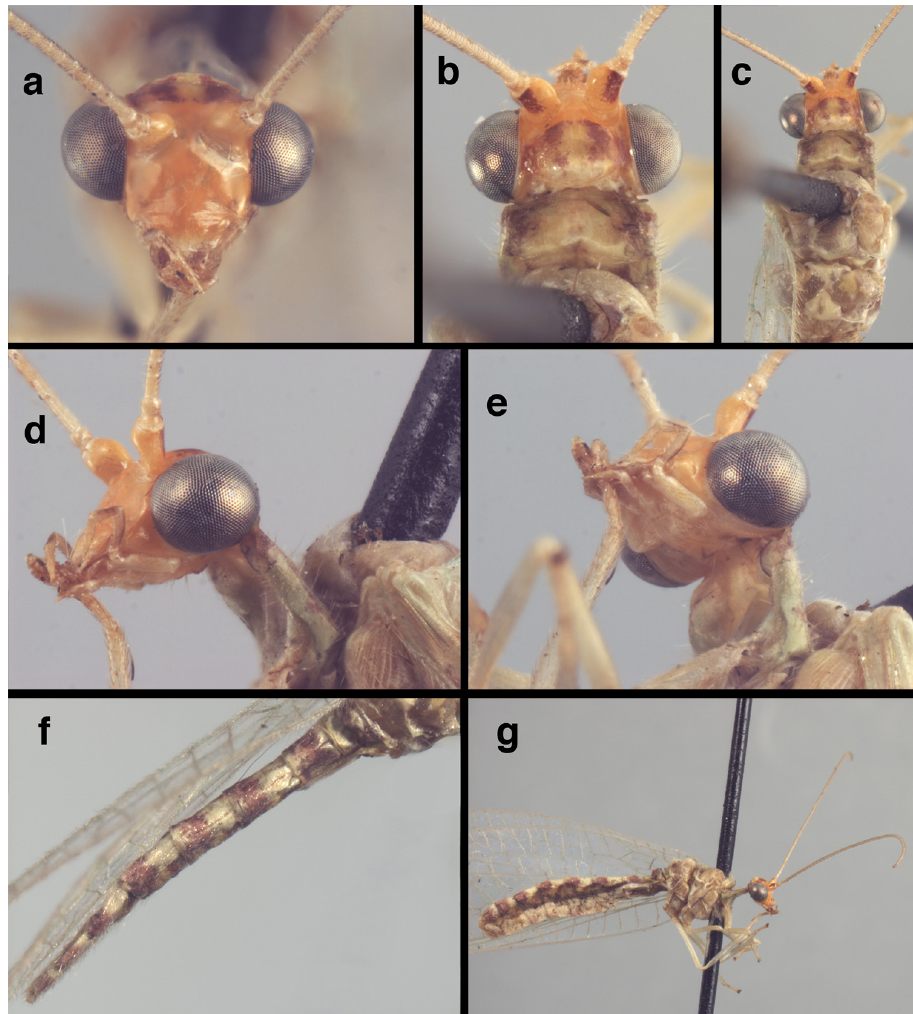
Figure 73. Ungla pennyi Tauber, sp. n. External features, ( a ) head, frontal ( b ) head, prothorax, dorsal ( c ) head, thorax, dorsal ( d ) head, lateral ( e ) head, ventral ( f ) abdomen, dorsal ( g ) body, lateral (Costa Rica, Puntarenas, paratype, female,